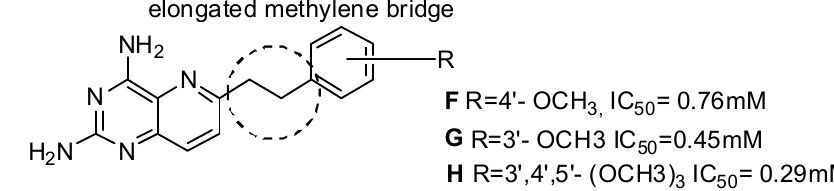
Figure 1. Structures of TMP analogues: pyrimidine modyfications, A – C , Sabry ’ s compounds D , E and Wang ’ s compound F – H .